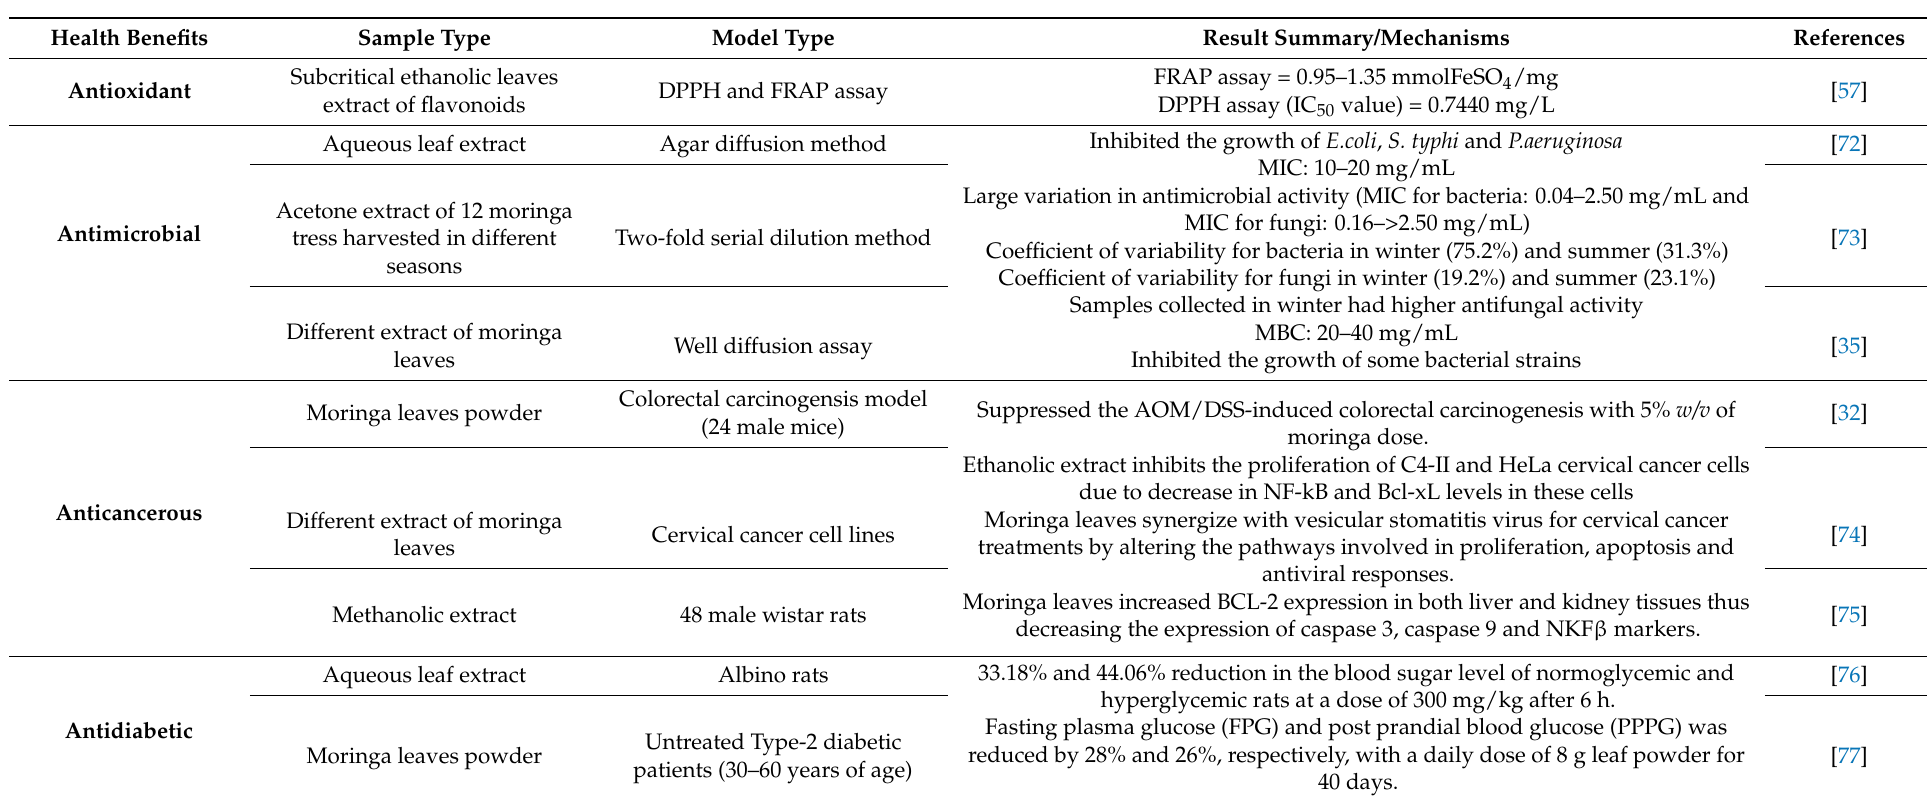
Table 3. Health benefits and mechanism of action demonstrated by Moringa oleifera